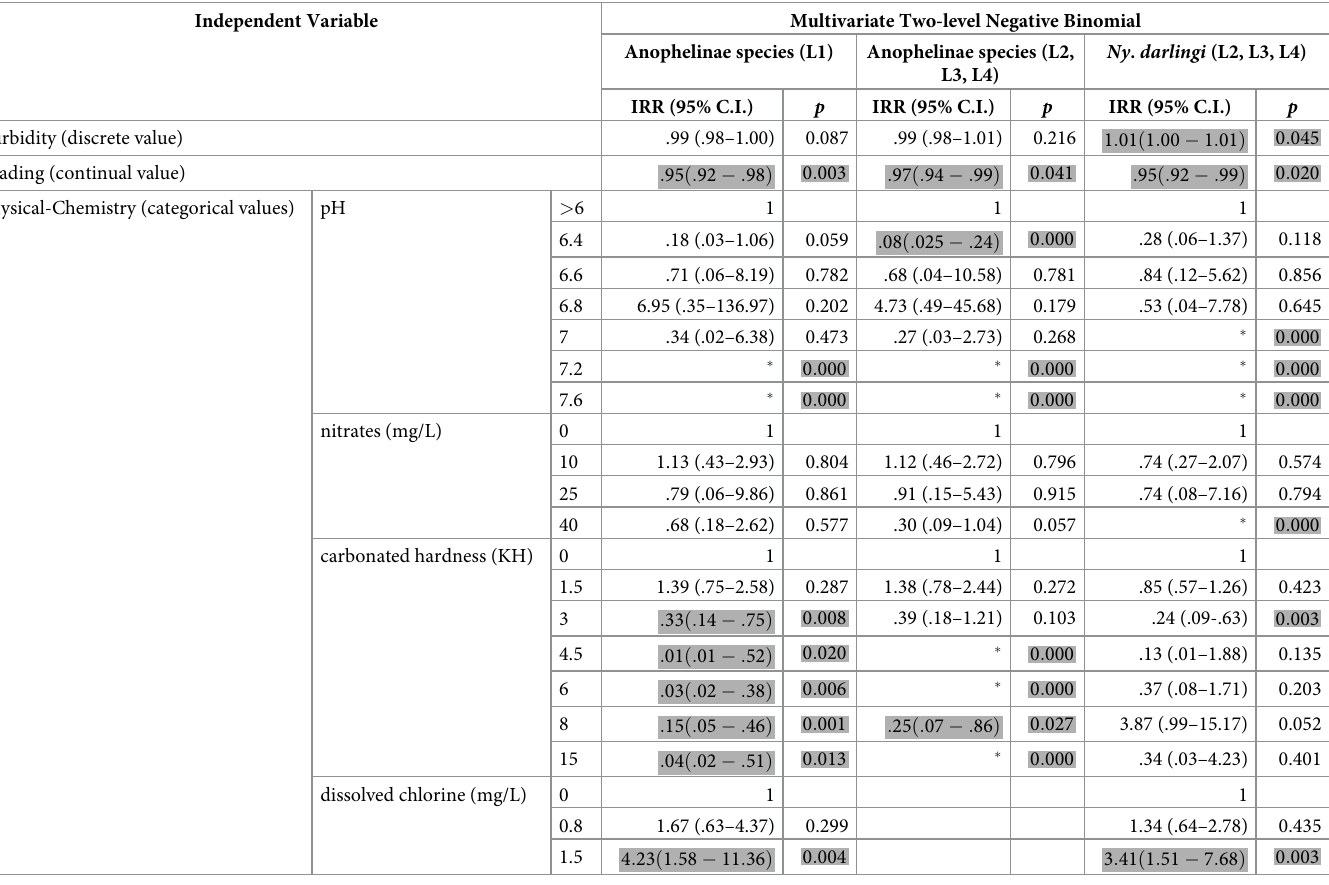
Table 4. Incidence Rate Ratio (IRR), 95% Confidence Interval and p values for Anophelinae species identify-group, for three-month survey multivariate two level negative binomial regression. Independent